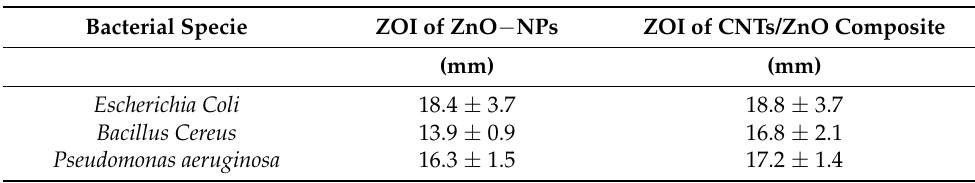
Table 1. ZOI range of ZnO − NPs and CNTs/ZnO on bacterial species. Bacterial